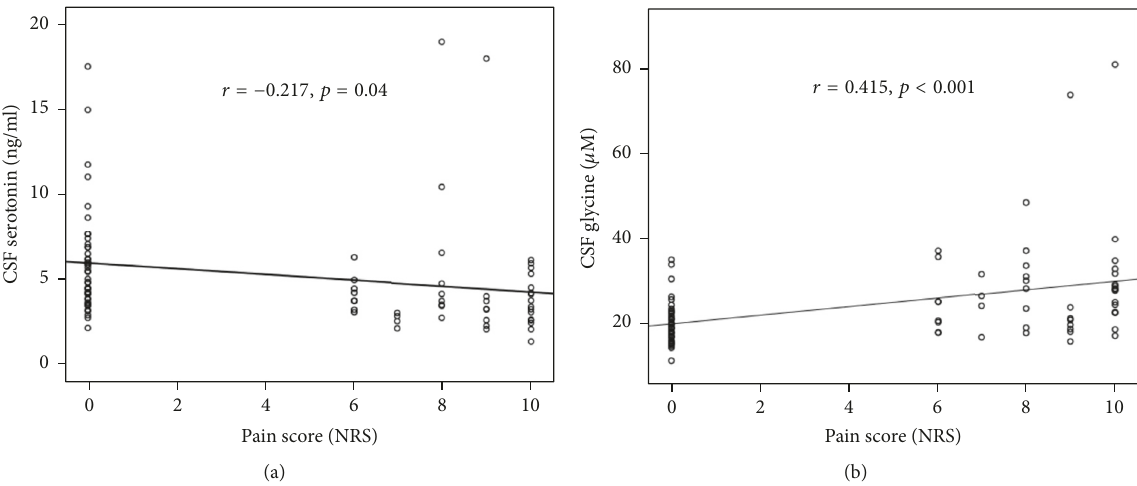
Figure 1: Correlation between pain scores and cerebrospinal fluid (CSF) levels of serotonin and glycine as measured by numerical rating scale (NRS): (a) CSF serotonin levels (Spearman’s coefficient: 𝑟 = −0.217 ; 𝑝 = 0.04 ); (b) CSF glycine levels (Spearman’s coefficient: 𝑟 = 0.415 ; 𝑝 < 0.001 ).